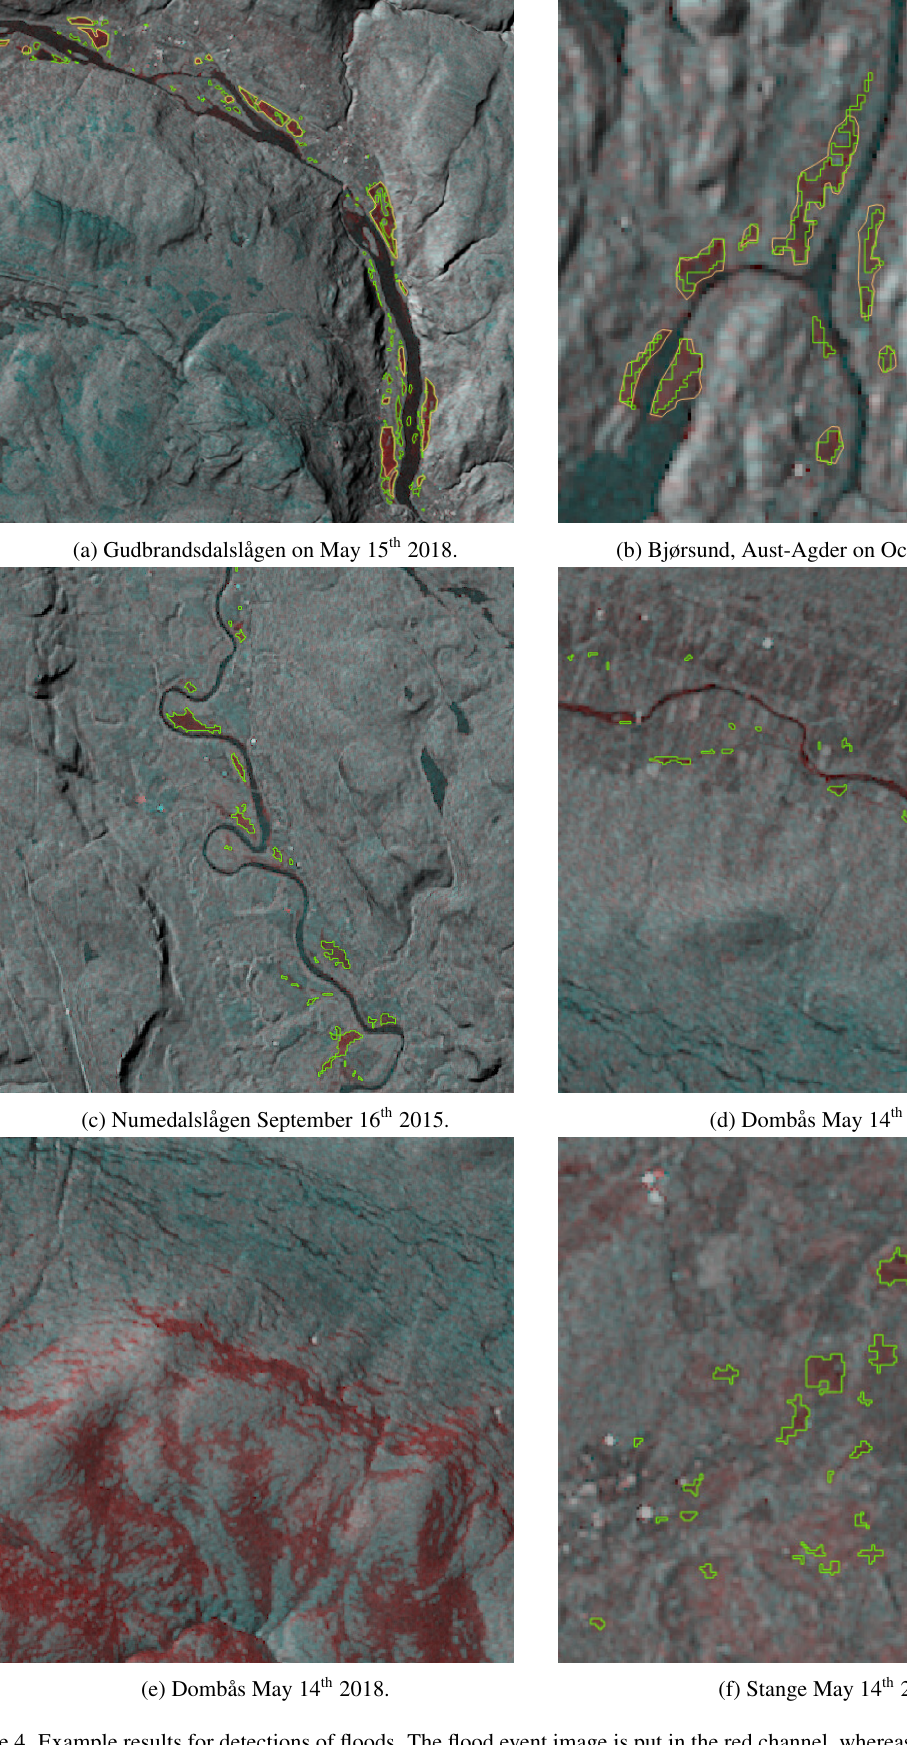
Figure 4. Example results for detections of floods. The flood event image is put in the red channel, whereas the reference image is put in the green and blue in the false color image. Orange polygons are annotated floods, whereas green polygons are predicted